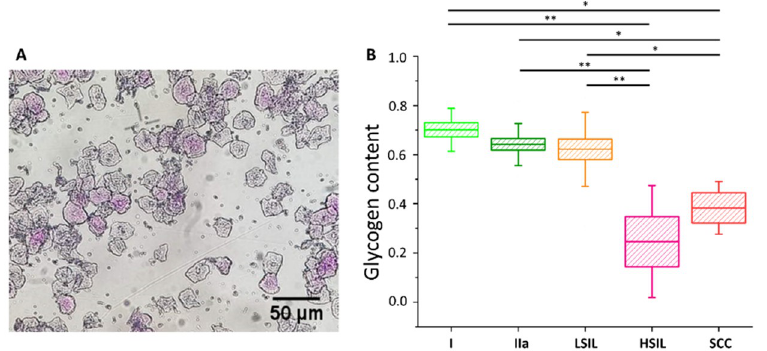
Figure 5. Glycogen content in the cytoplasm of cervical epithelial cells evaluated using a PAS staining method . An illustrative photograph of a sample of cervical epithelial cells stained by PAS ( A ). The analysis of the glycogen content ( B ) in the cytoplasm of cervical epithelial cells according to the division of patients into groups I (bright green), IIa (dark green), LSIL (orange), HSIL (pink) and SCC (red). Glycogen content was determined by optical evaluation in a light microscope after PAS staining by calculations of the average percentage of stained cells among all cells stained in individual groups. Each point on the graph corresponds to the average result for one patient (B). Values were given as mean ± SEM and were shown in box plots: mean (horizontal line), SEM (box), minimal and maximal values (whiskers). * p < 0.05, ** p < 0.01.